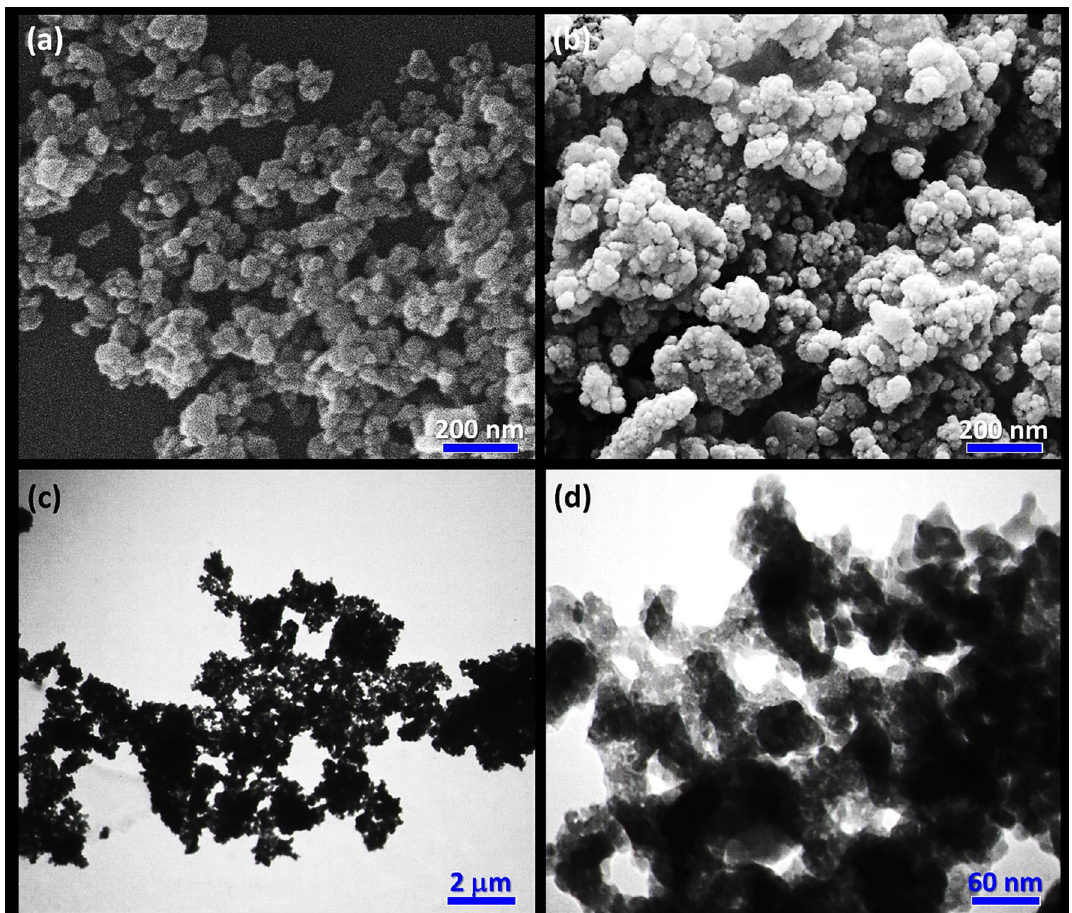
Figure 4. SEM images of ( a ) Fe 3 O 4 NPs, ( b ) Fe 3 O 4 @SiO 2 /TABHA NPs, and ( c , d ) TEM images of Fe 3 O 4 @SiO 2 / TABHA NPs.